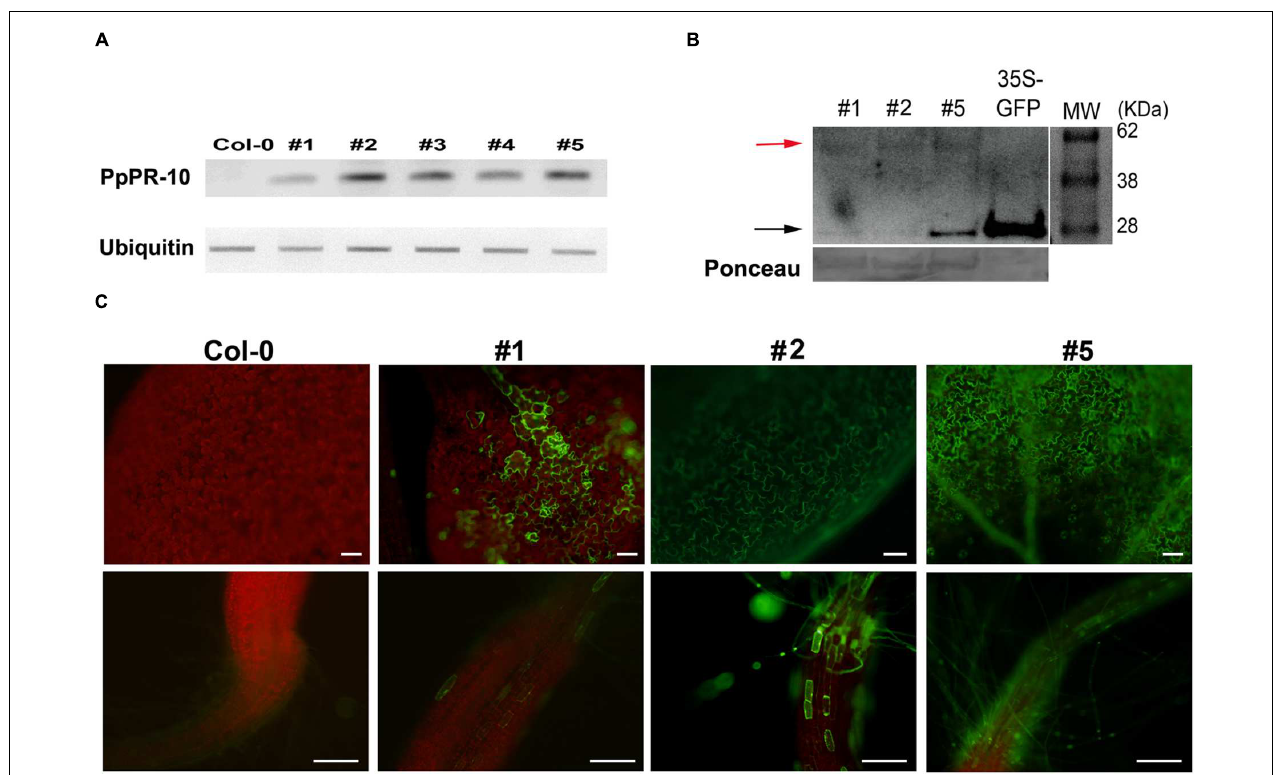
FIGURE 7 | Overexpression of PpPR-10 in Arabidopsis . (A) Representative semiquantitative RT-PCR analysis of PpPR-10 transcript levels in Arabidopsis PpPR-10 transformed lines. The ubiquitin gene AT3G52590 was used as an internal control. (B) Immunoblot detection of PpPR-10-GFP fusion protein (red arrow) in transgenic Arabidopsis lines At 35S:PpPR-10-1 (#1), At 35S:PR-10-2 (#2) and At 35S:PR-10-5 (#5). Ten micrograms of total soluble proteins were separated in SDS-PAGE and Western blot analysis was performed using an antibody for GFP. As a control for GFP detection, a protein sample from transgenic Arabidopsis plants expressing constitutively unfused GFP (35S-GFP) was included. The 27 kDa protein corresponds to cleaved GFP (black arrow). (C) Fluorescent microscopy of leaves and roots of wild type (Col-0), At 35S:PpPR-10-1 (#1), At 35S:PR-10-2 (#2) and At 35S:PR-10-5 (#5) Arabidopsis lines. The scale bars represent 50 µ